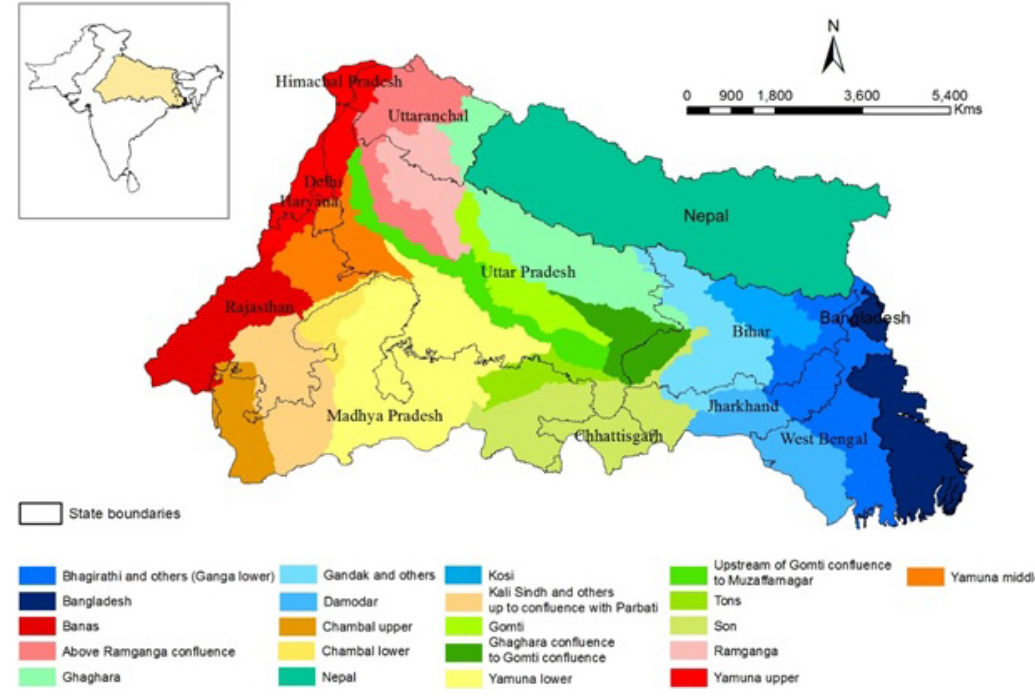
Figure 1. The Ganges River basin and its sub-basins. Table 1. Water resources of the riparian countries of the Ganges River.